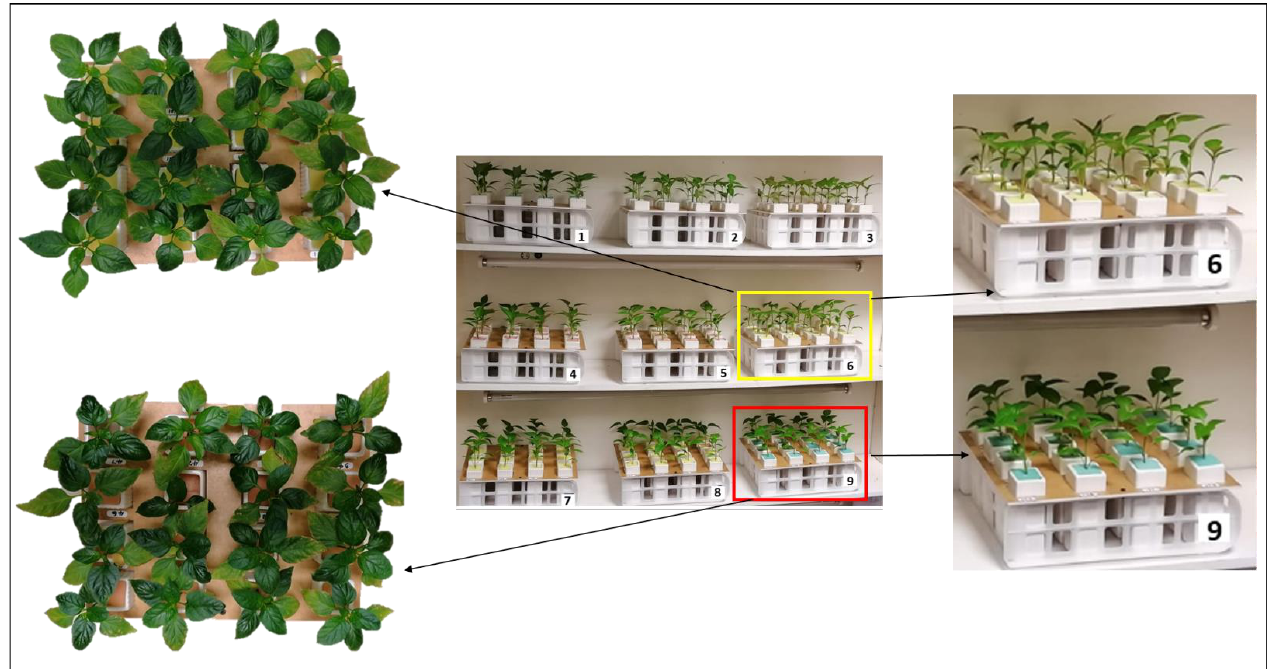
Figure 1. Treated and control seedlings in a block design ( n = 9).